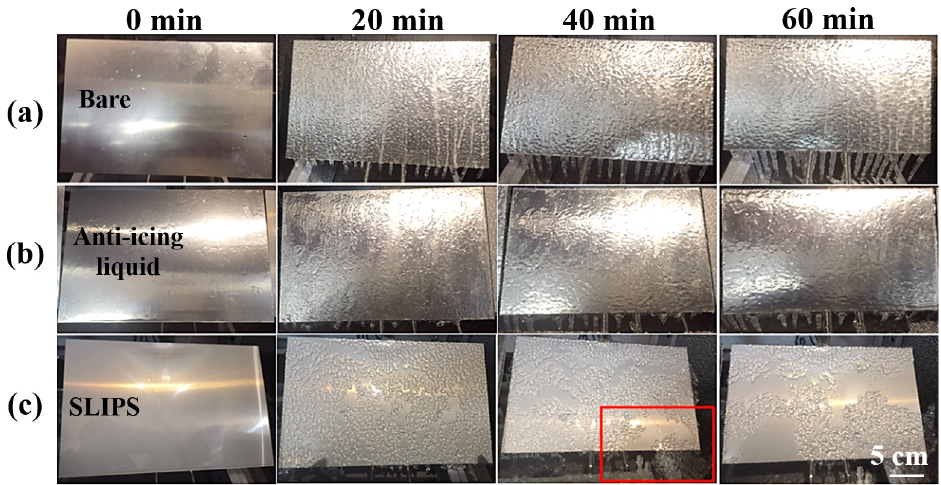
Figure 8. Icing process of a bare aluminum surface ( a ), anti-icing- fl uid-coated sample ( b ) and SLIPS ( c ) with a 60° tilting angle at − 6 °C for 60 min.